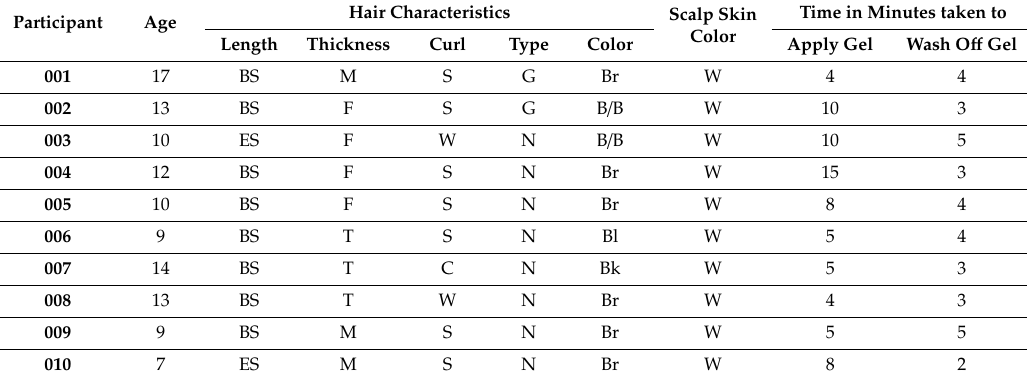
Table 2. Field study of Paranix Eggs Locator Gel: Demographic characteristics of participants and time required to apply and wash o ff .